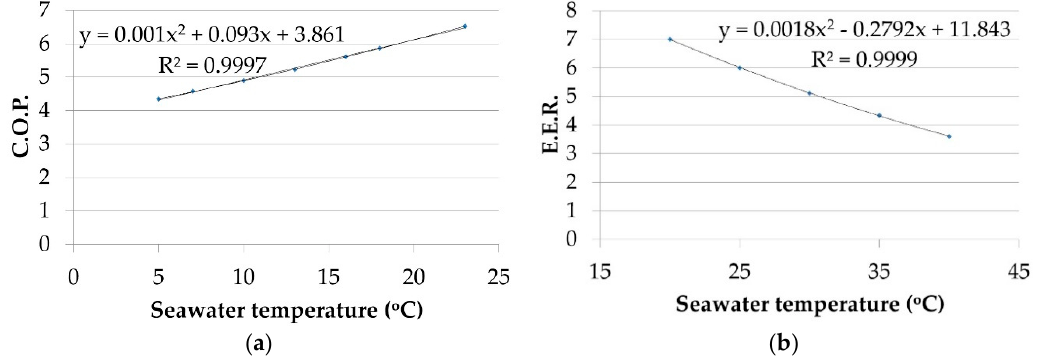
Figure 9. ( a ) Typical COP curves for a geothermal heat pump. ( b ) Typical EER curves for a geothermal heat pump.